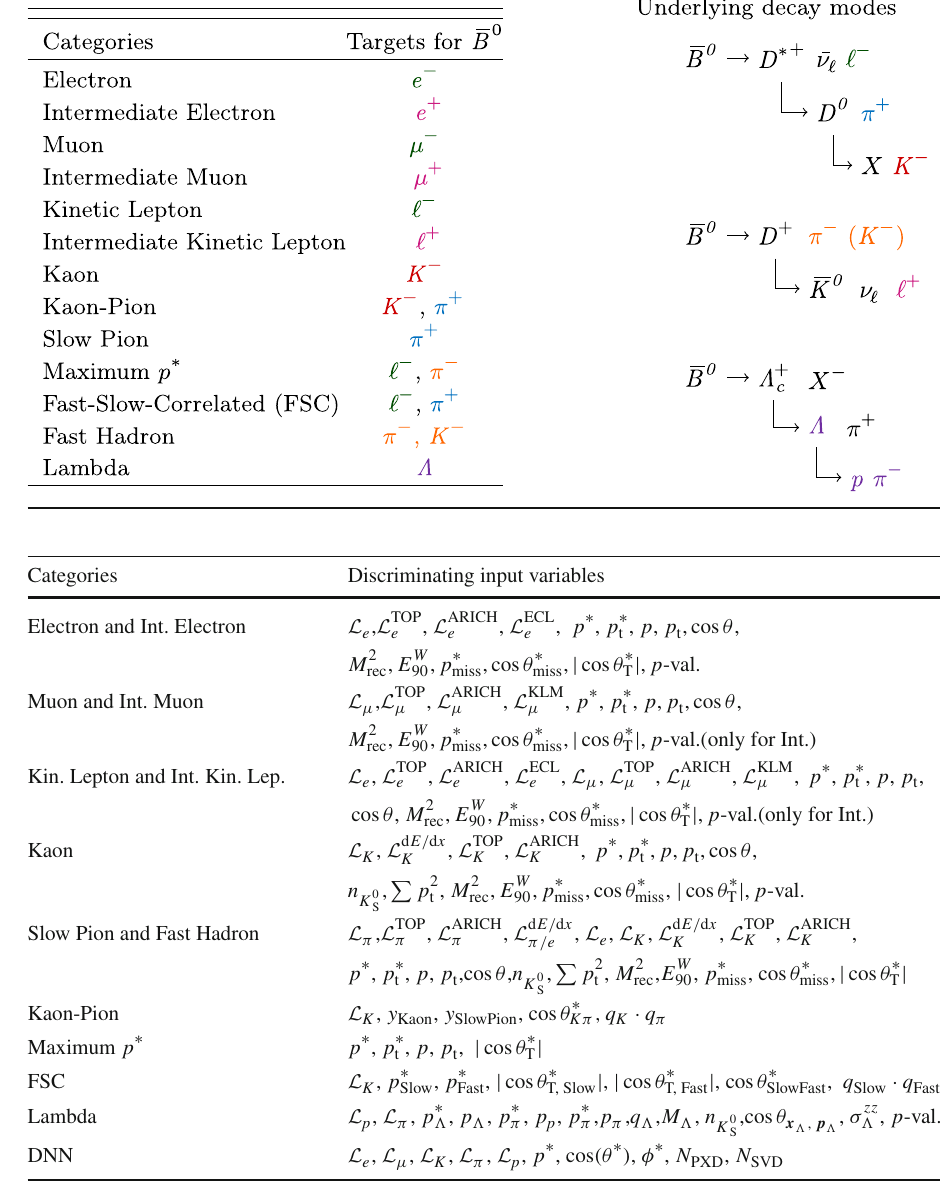
Table 1 Tagging categories and their targets (left) with examples of the considered decay modes (right). The target particles for each category are shown using the same colors on the left and on the right. Here, ∗ p stands for momentum in the ± center-of-mass frame, (cid:4) for − − charged leptons ( μ or e ) and X for other possible particles in the decays